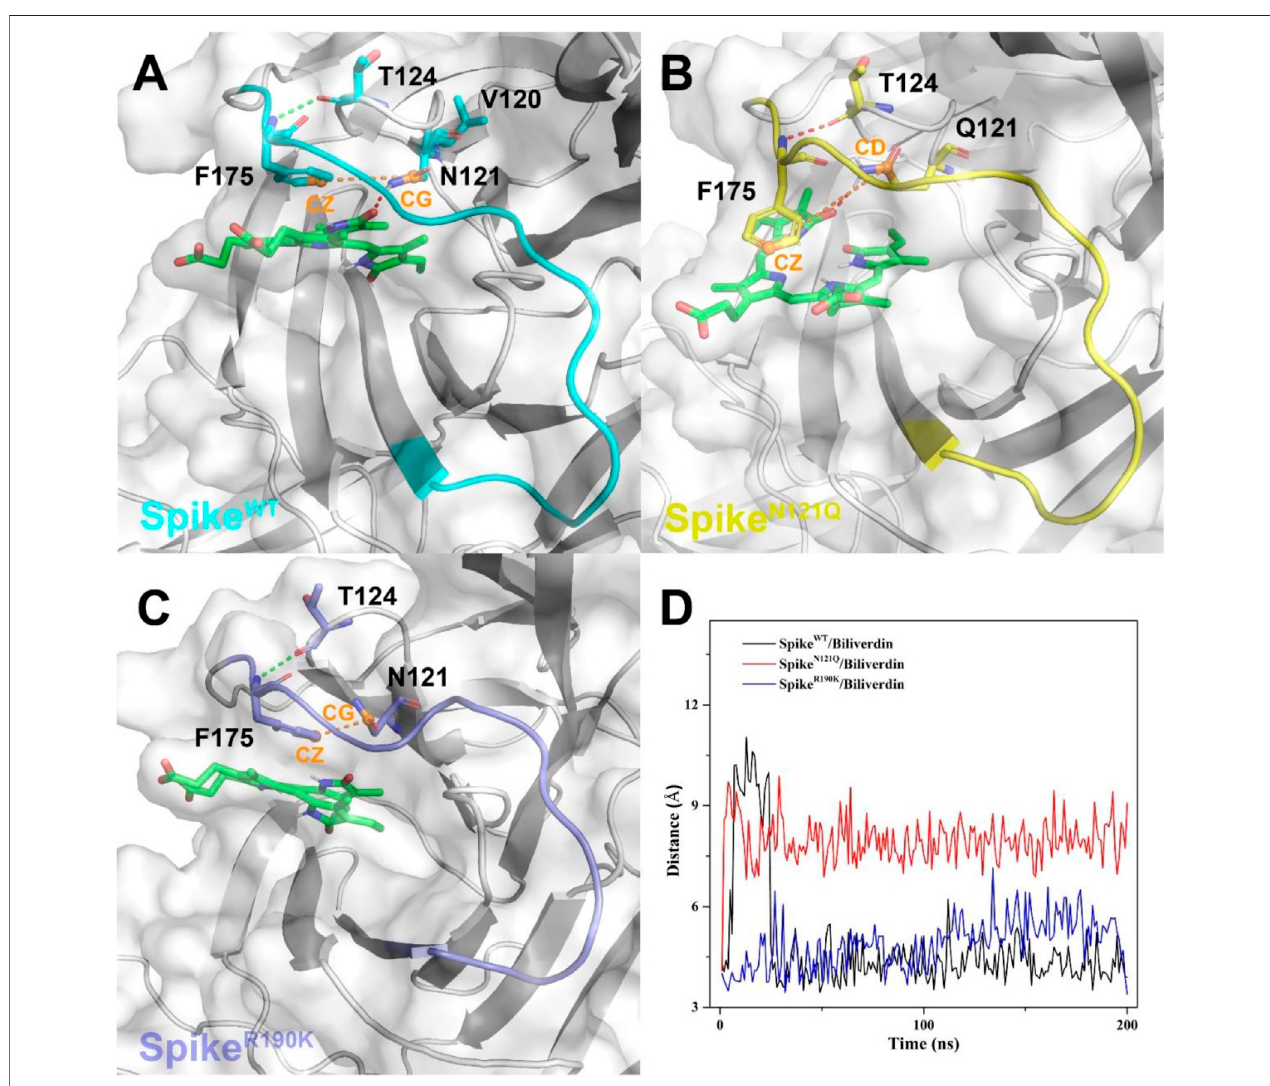
FIGURE 4 | The binding interaction between the SARS-CoV-2 spike and biliverdin in (A) Spike WT /Biliverdin, (B) in Spike N121Q /Biliverdin, and (C) in Spike R190K / Biliverdin. (D) The distance between the CZ atom of Phe175 and the CG atom of Asn121 (or CD atom for the case of Gln121) was measured to reveal the de fl ection process of